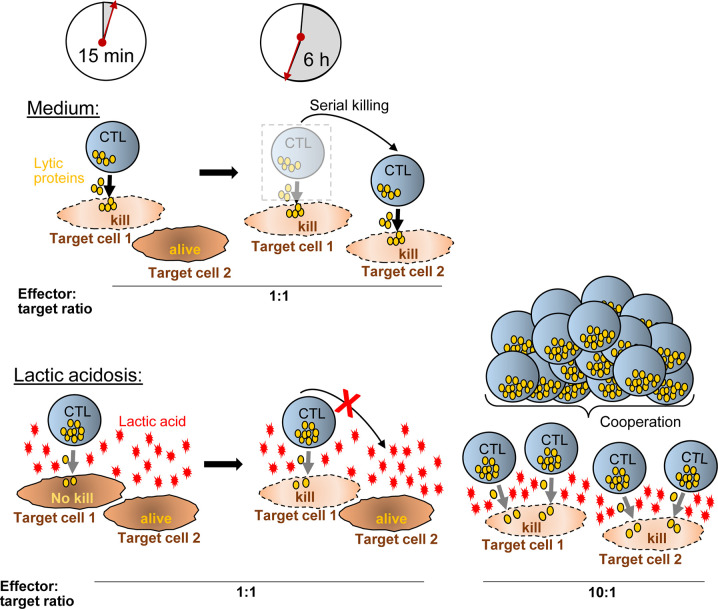
Hypothetical model how CTL-mediated killing is moderated in lactic acid. In medium, a CTL degranulates (yellow granules) strongly after synaptic contact with target cell-1 and kills the target cell quickly (~15 min). Within the next hours (6 h exemplified), the CTL moves to additional targets (target cell-2) and may kill them as well (serial killing). Lactic acid reduces the efficacy of degranulation (less granules released) and impairs CTL motility, thereby reducing serial killing and killing potency compared to medium. Increasing the ratio of CTL to tumor cells (i.e., from 1:1 to 10:1) (right), motility arrest and reduced degranulation of a single CTL are no longer influential factors for killing potency. Killing of multiple targets is possible through T cell cooperation even in inhibiting conditions such as lactic acidosis.